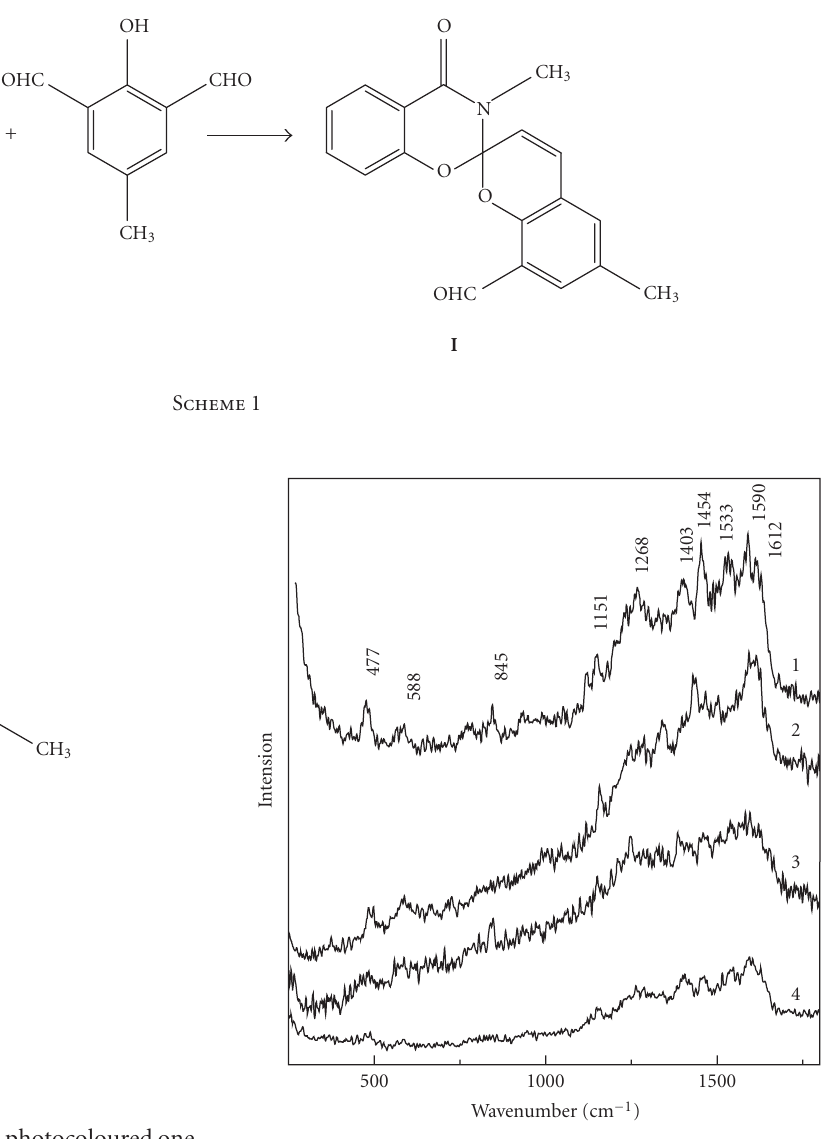
Figure 1: The giant Raman spectra of compound II (c) adsorbed on the unannealed (1,2) and annealed (3,4) silver films ( λ exc = 514HM (1,3); λ exc = 488HM